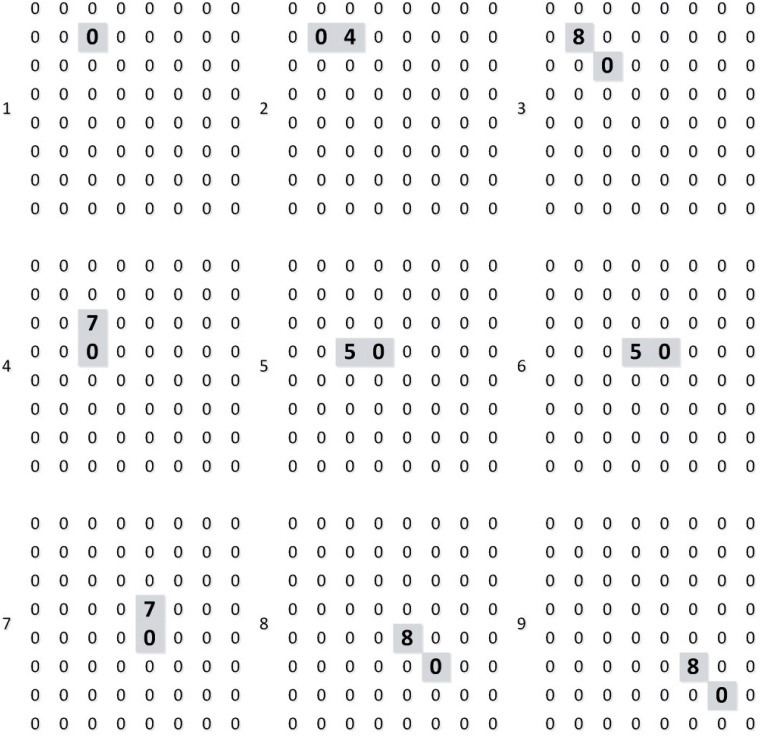
Output of layer 4.